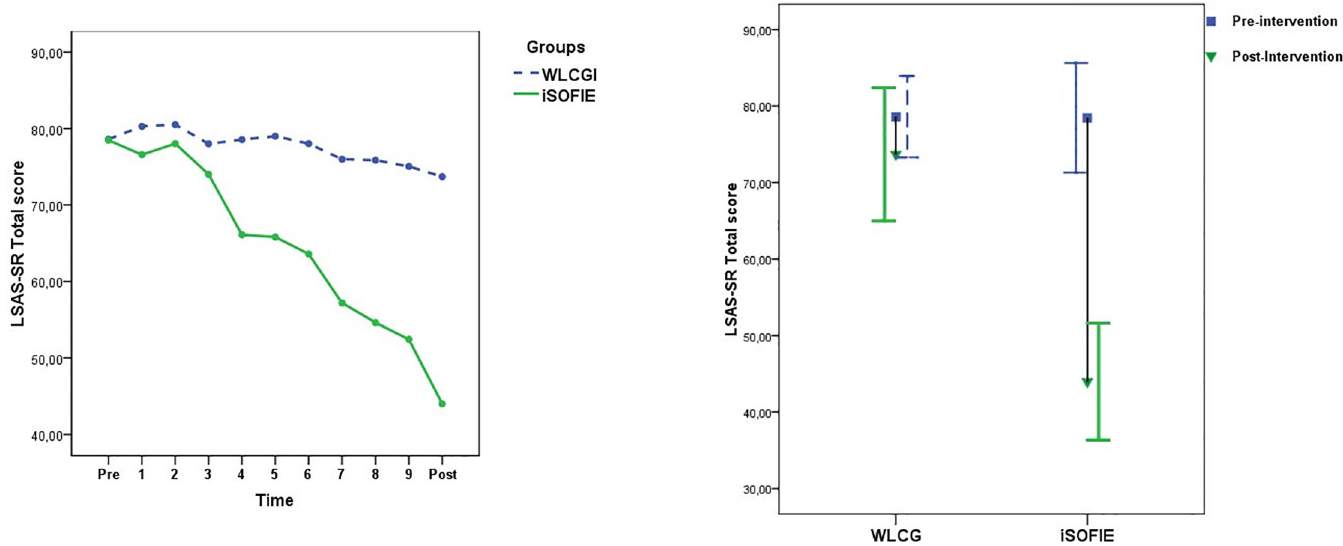
Fig 2. Social anxiety levels for the two groups throughout the iSOFIE program. Abbreviations: iSOFIE = the iSOFIE intervention group; WLCG = Wait List Control Group; Pre = Pre-intervention assessment, Post = Post-intervention